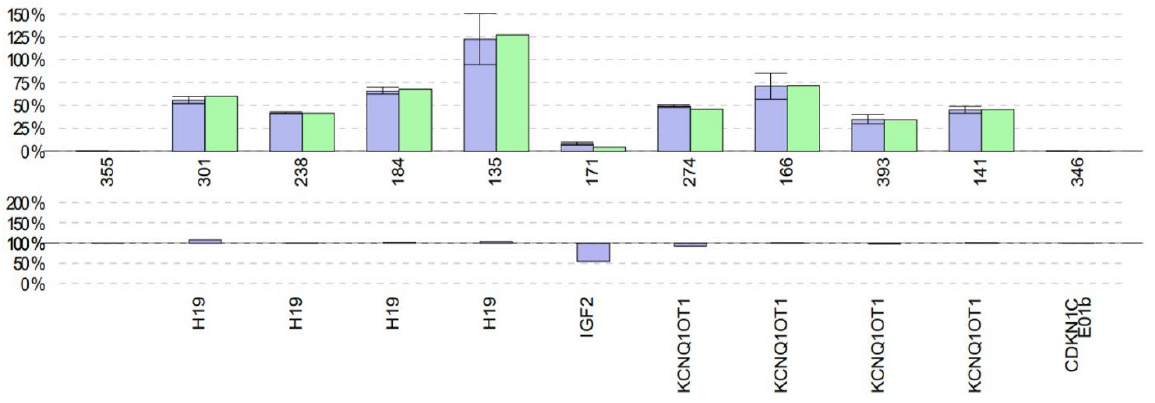
Figure 2. IGF2 hypomethylation revealed by H19DMR MLPA. While no difference between patient (green) and controls (purple) (upper panel) was observed for four H19 , four KCNQ1OT1 and one CDKN1C probe, IGF2 methylation was 50% lower in the patient compared to the controls (lower panel, purple).